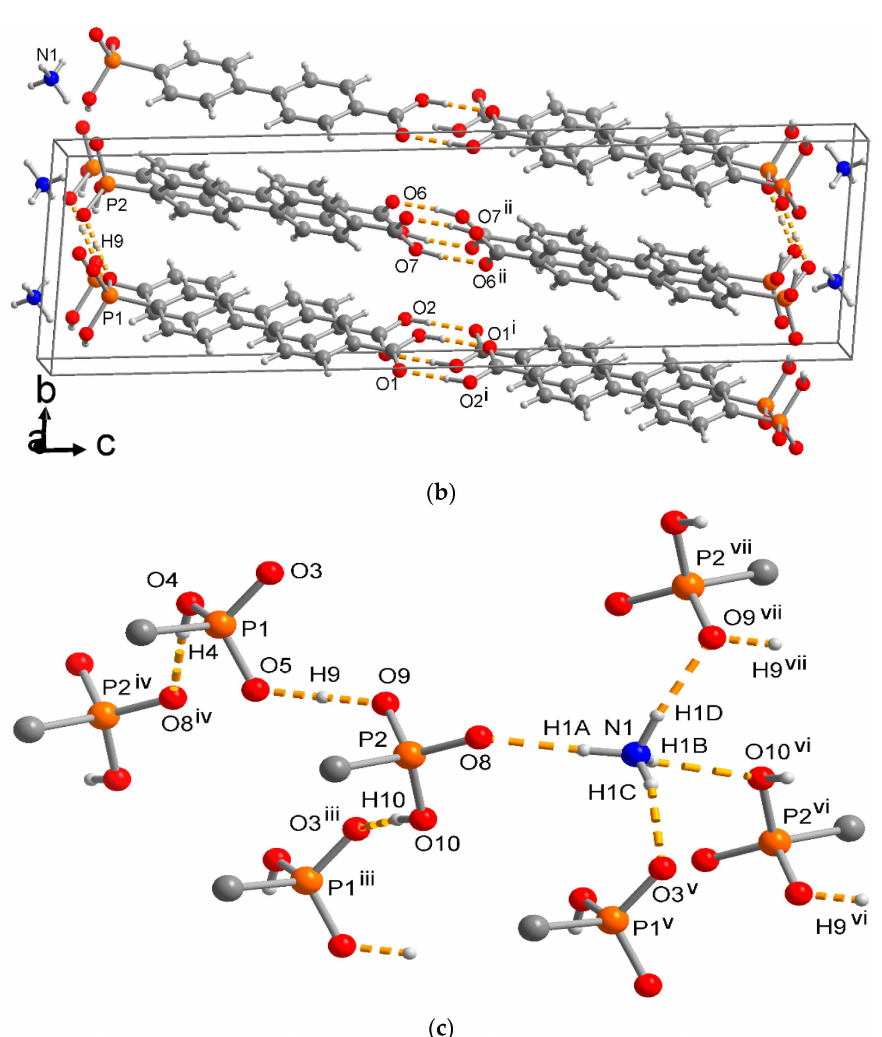
Figure 1. ( a ) Asymmetric unit of 1 (50% thermal ellipsoids); ( b ) unit-cell packing diagram with tail-to-tail arrangement of the carboxylic acid groups (showing only the carboxyl and the O9-H-O5 H bonds for clarity); and ( c ) full hydrogen-bonding arrangement around the NH 4+ cation and the phosphonate and phosphonic acid groups. Details of the H-bonding interactions (orange dashed lines) are given in Table 1, selected non-hydrogen bonds and angles in Table 2. Symmetry transformations: